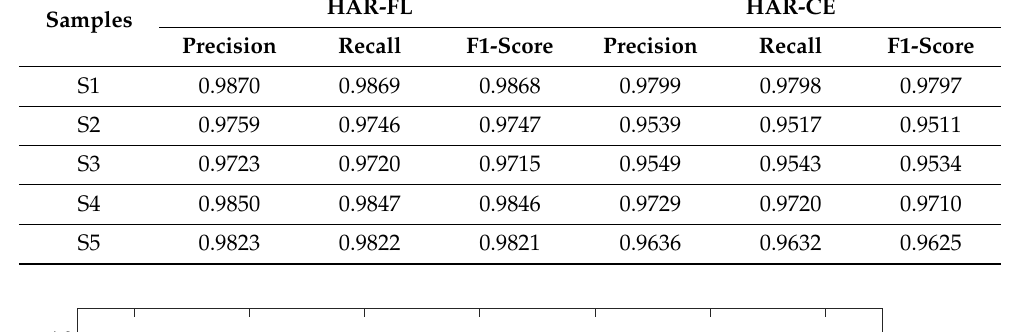
Table 7. Comparison of HAR-CE and HAR-FL.